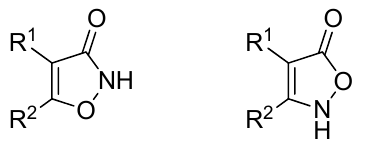
Figure 1. The structure of isoxazolone derivatives.